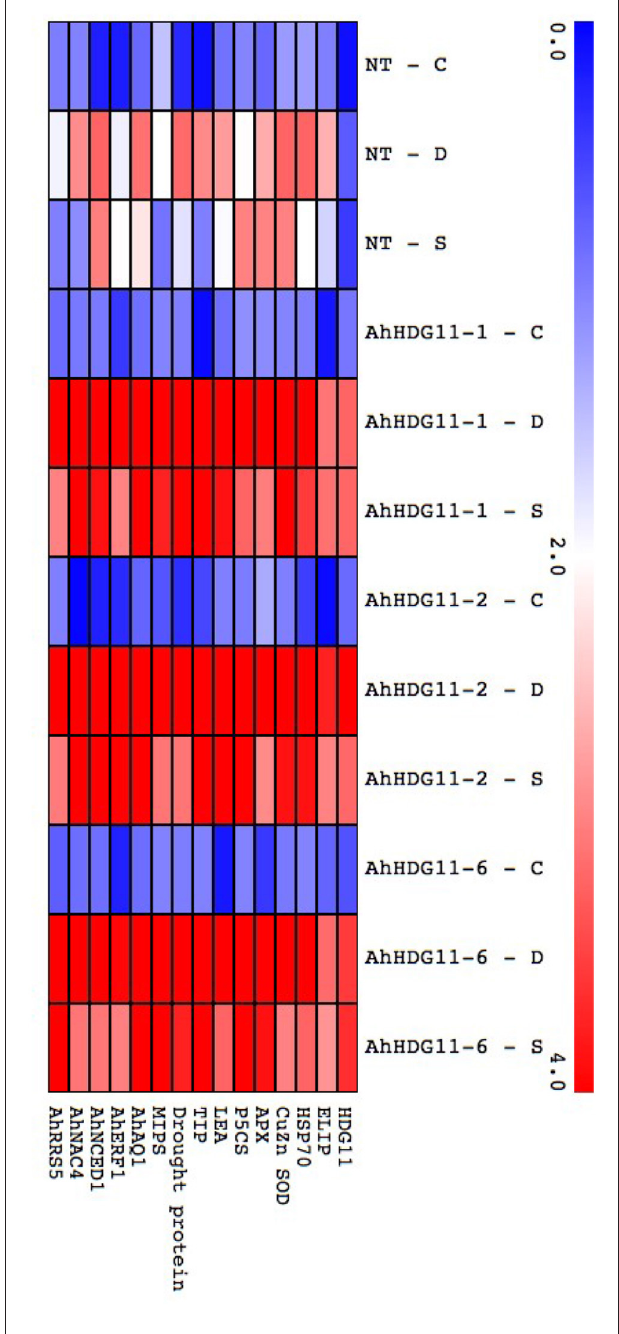
FIGURE 10 | Gene expression analysis of known stress responsive genes in non-transgenic (NT) and Transgenic lines. qRT-PCR analysis of T 3 generation peanut transgenic lines for the expression of known stress responsive genes under induced drought and salt lysimetric experiments. Heat map showing the expression of known stress responsive genes of stress gene network in non-transgenic (NT) and transgenic plants under well-water, drought and salt stress conditions. The log 2 fold change scale is indicated in the heat